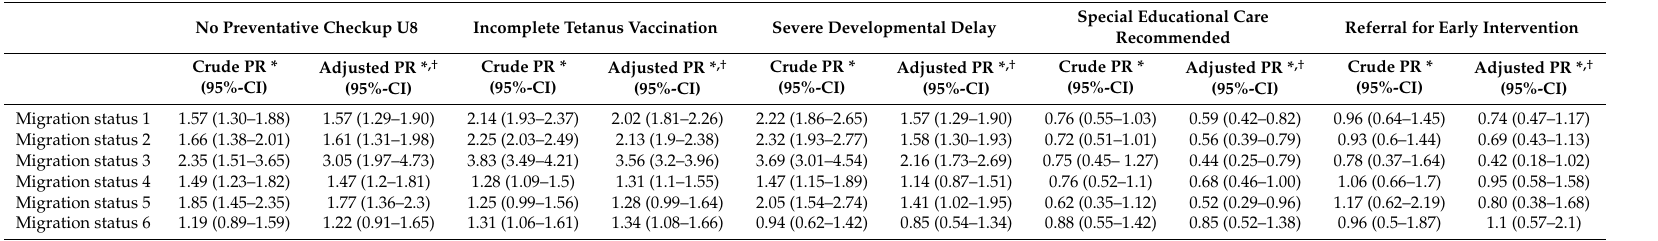
Table 3. Risks for severe developmental disorders according to migration